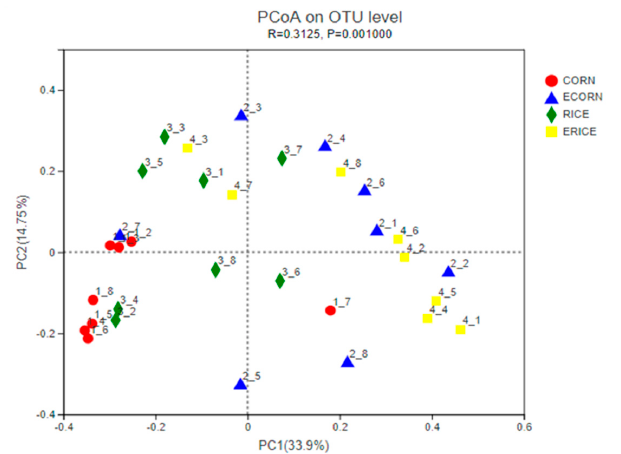
Figure 4. Principal coordinate analysis (PCoA) of bacterial community structures among the four groups. Treatments were corn as the main cereal type (CORN), or half of the corn replaced by extruded corn (ECORN), broken rice (RICE), and extruded broken rice (ERICE), respectively. Taxonomic classifications of bacterial 16S rRNA at phylum levels on day 28 are shown (Figure 5). In total, 13 phyla and 83 families were identified in fecal samples on day 28. The most dominant bacterial phyla were Firmicutes , which accounted for 91% of total bacteria. Additionally, both CORN and RICE groups showed significantly higher Actinobacteria levels than ECORN and ERICE ( p < 0.05).